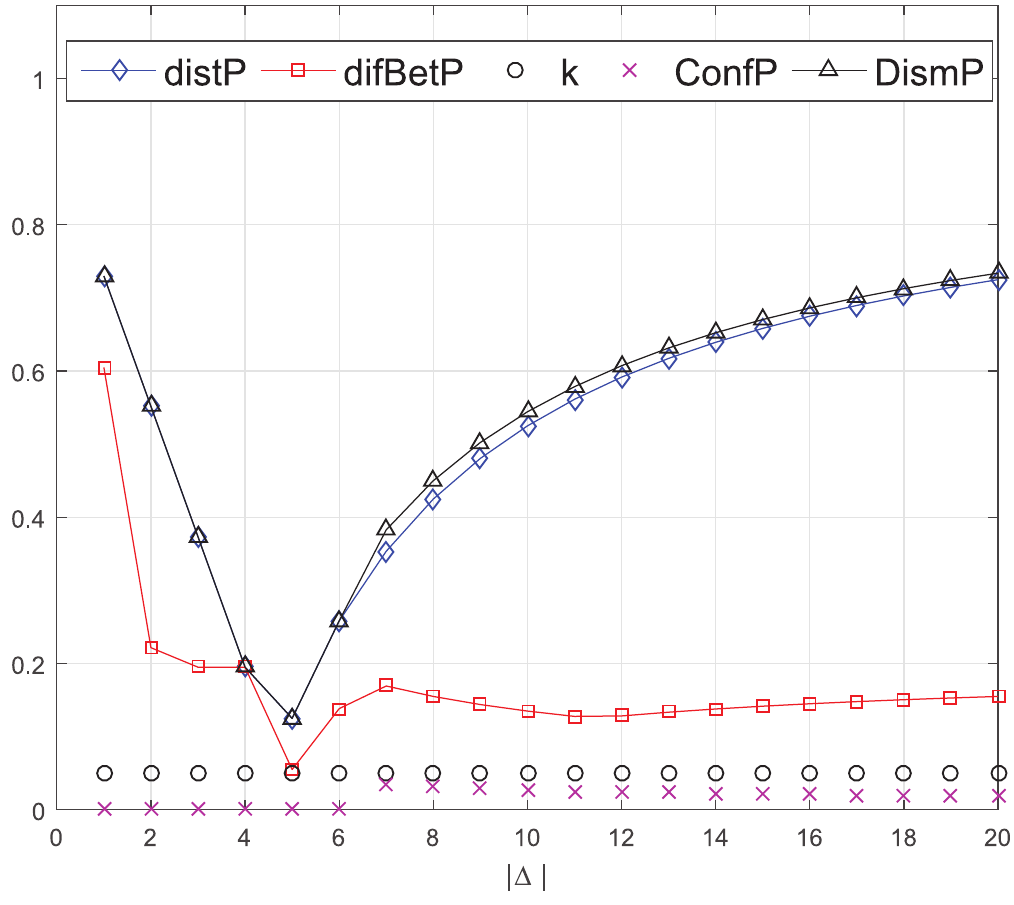
Fig 2. Comparison of dissimilarity measuresof the 1st pair